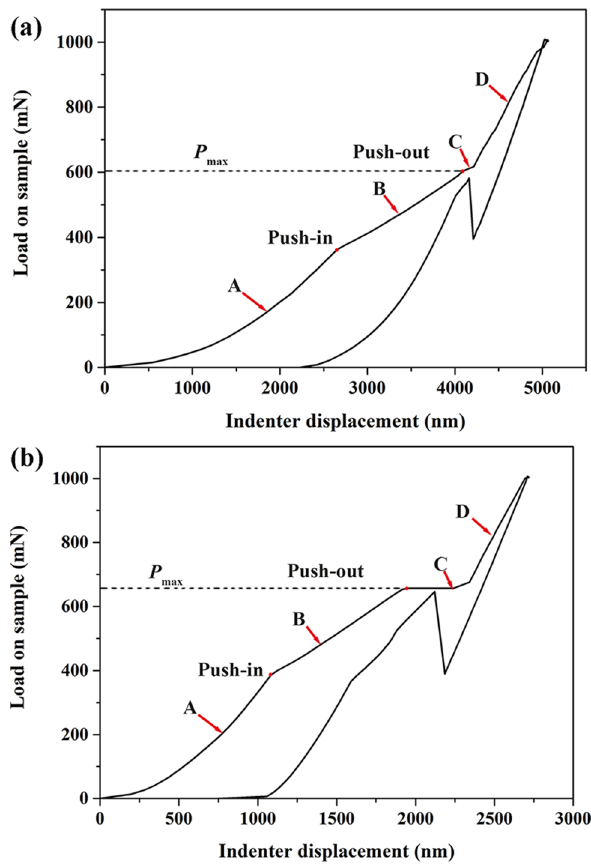
Figure 8. Representative indentation curve of single-fiber push-out tests on the SiC f /SiC minicomposite: ( a ) with CaWO 4 interphase coating and ( b ) without interphase coating.